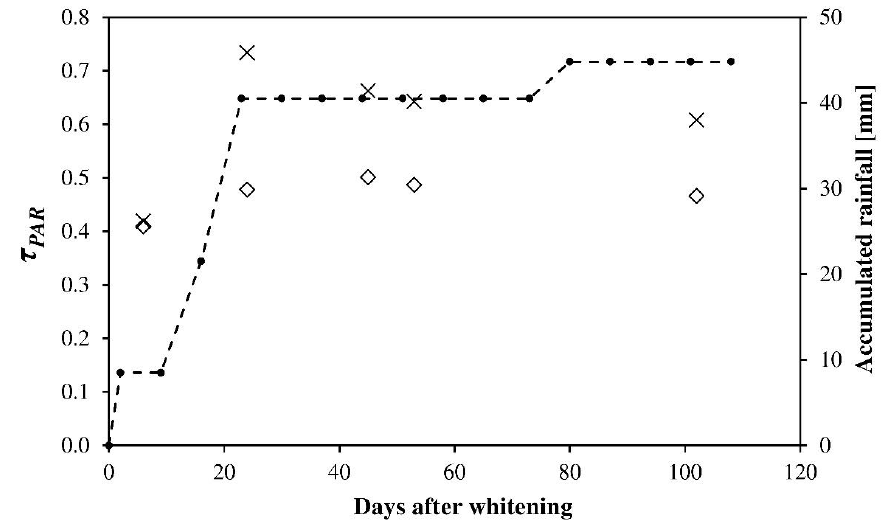
Figure 7. Transmissivity (to PAR radiation) of the greenhouse cover in sector 1 with ASP BE ( × ) and in sector 2 with ASP F ( ♦ ). Initial concentration of the product applied 25/100 (0.25 kg L − 1 ). Accumulated rainfall according to data from the Almer í a airport weather station (- • -).